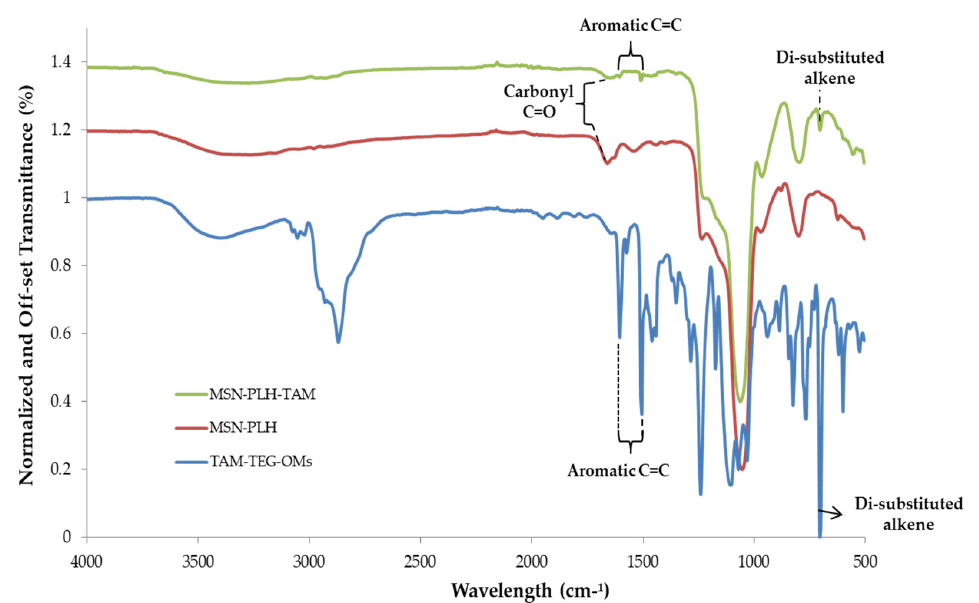
Figure 6. FT-IR spectra of MSN-PLH-TAM synthesized from the reaction between MSN-PLH (2) and TAM-TEG-OMs, via an S N 2 mechanism with mesylates as leaving groups. MSN-PLH-TAM demonstrated characteristic peaks of PLH and TAM molecules, including secondary amide C=O, aromatic C=C and di-substituted alkenes.